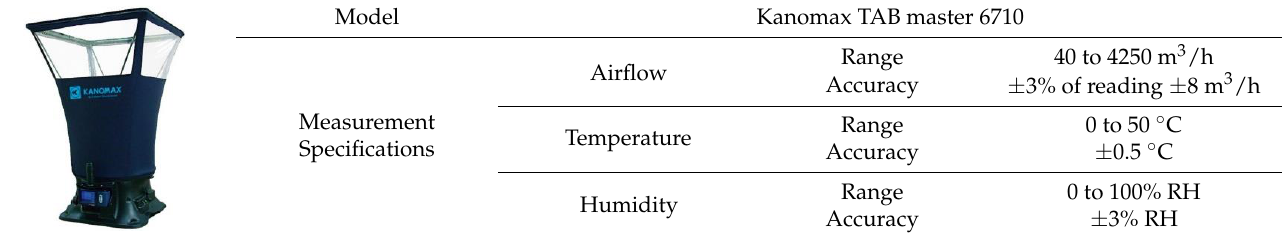
Table 6. Data logger specification.